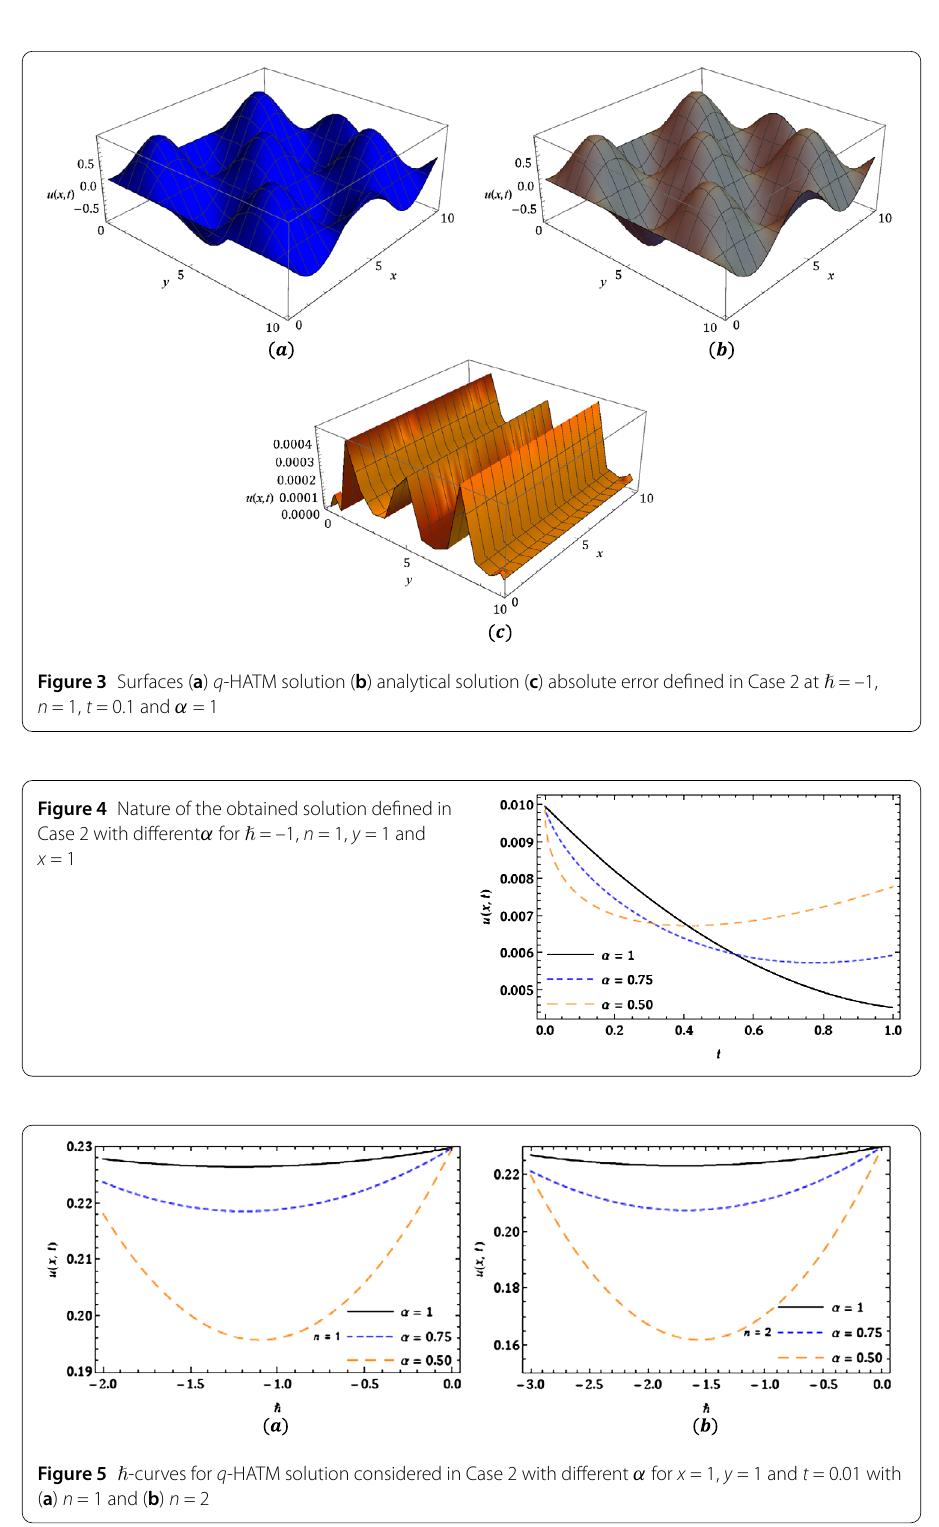
the behaviour of the achieved solution respectively in Fig. 2 and Fig. 5. These curves aid to control and adjust the region of the convergence for q -HATM solution. Meanwhile, the horizontal line in the plots represents the convergence region. For a particular (cid:2) ,